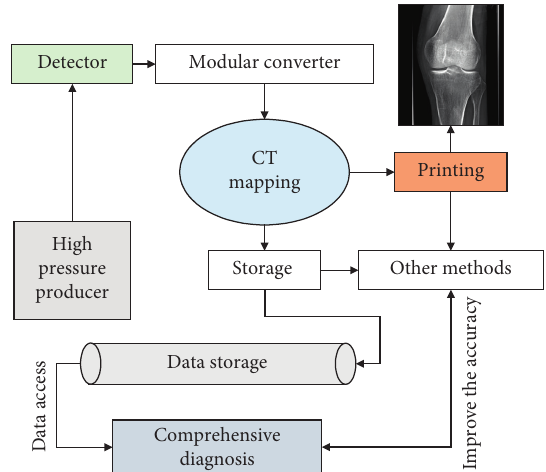
Figure 1: The schematic diagram of 3D-CT mapping used in the ACL